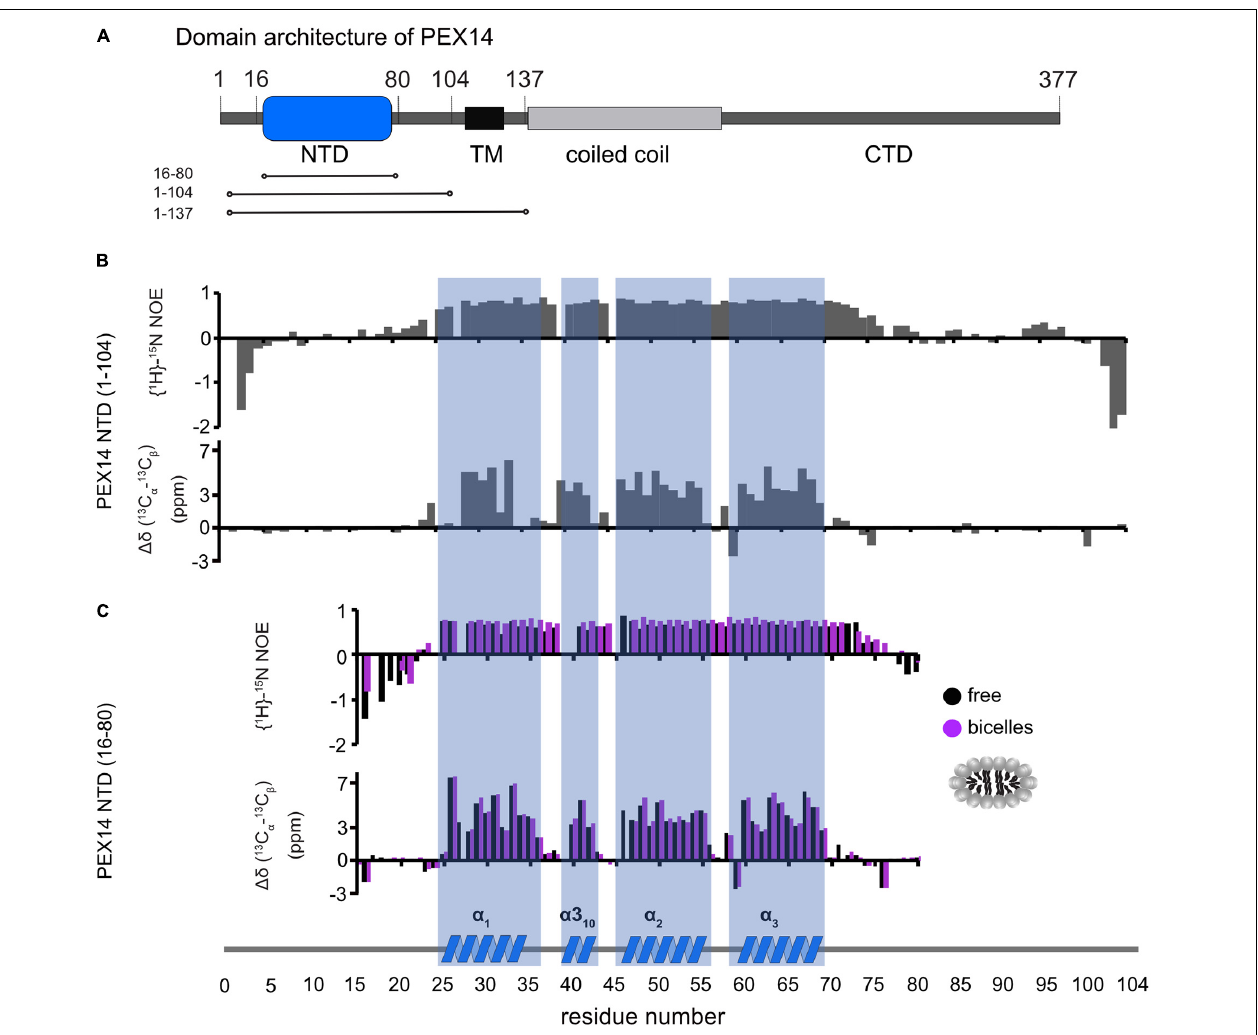
FIGURE 3 | Human PEX14 NTD secondary structure. (A) Human PEX14 comprises a globular N-terminal domain (NTD) and a short transmembrane span which is followed by a coiled coil region and an unstructured C-terminal domain. (B,C) { 1 H}- 15 N heteronuclear NOE (top) and 13 C secondary chemical shifts (bottom) of (B) the PEX14 NTD (residues 1–104) free in solution and (C) of the globular domain (residues 16–80) in solution (black boxes) and in the presence of bicelles (magenta